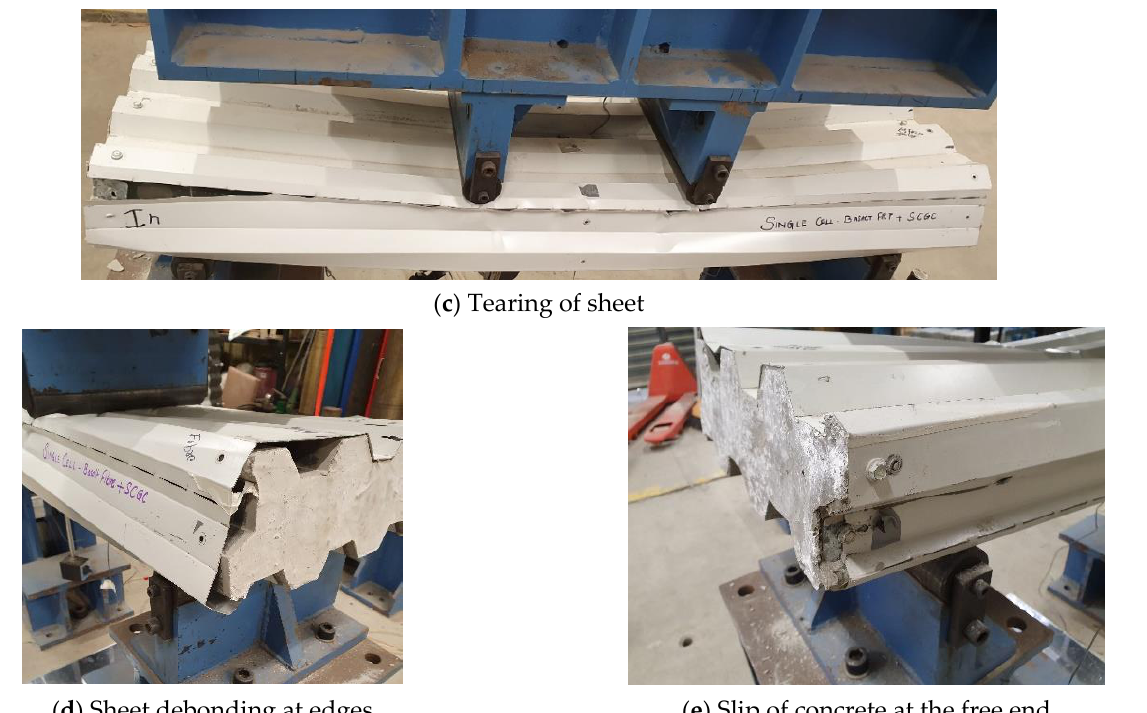
Figure 8. Failure modes of single-cell panels.